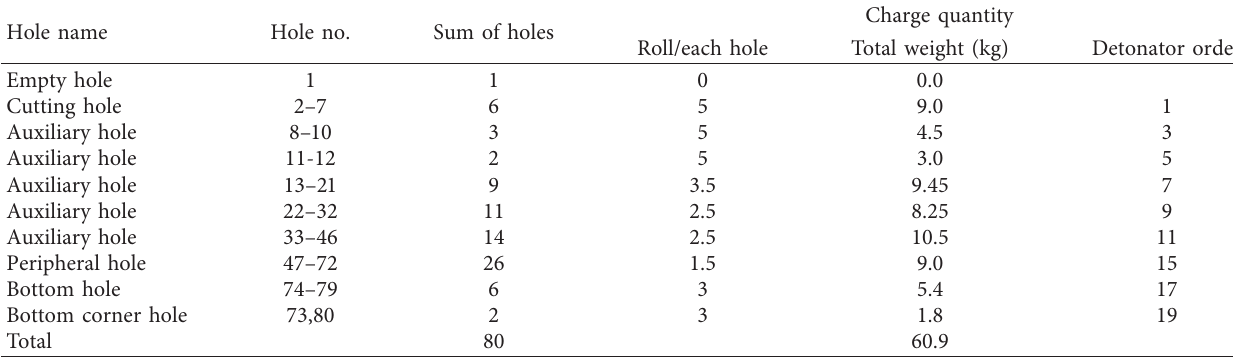
Table 1: Blasting parameters for the designed